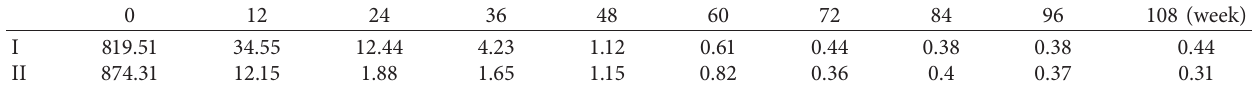
Table 2: HBeAg data of successful-treatment group.